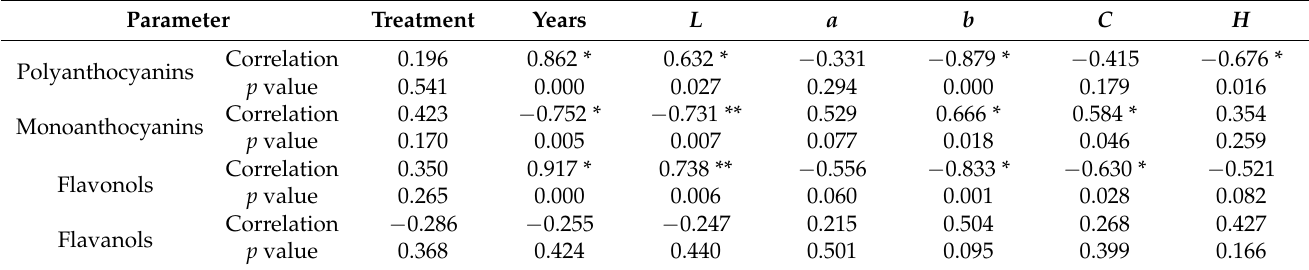
Table 6. Pearson’s coefficient of vintage and treatments on wine flavonoids and colorimetric parameters.